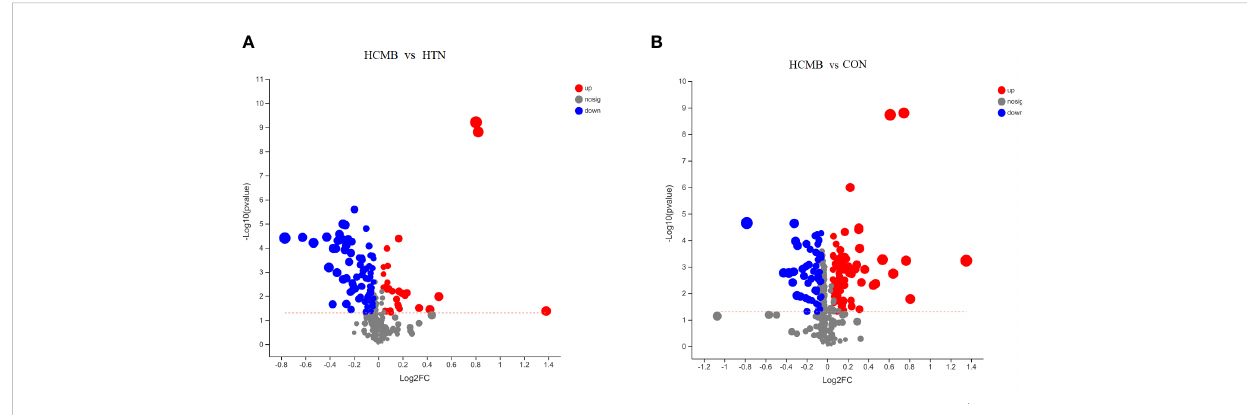
FIGURE 6 Volcano plots of the differences between groups. (A) . Volcano plots of intergroup differences between the two groups of HCMB vs HTN. (B) . Volcano plot of intergroup differences between two groups of HCMB vs CON. The horizontal coordinate of the graph is the value of the fold change in metabolite expression difference between the two groups, i.e. log2FC, and the vertical coordinate is the value of the statistical test for the difference in metabolite expression change, i.e. -log10(p_value), the higher the value the more signi fi cant the expression difference, the values of the horizontal and vertical coordinates have been logarithmicized. Each point in the graph represents a speci fi c metabolite and the size of the point indicates the Vip value. The points on the left are metabolites with down-regulated expression differences and the points on the right are metabolites with up-regulated expression differences, with the more signi fi cant expression differences occurring to the left, right and top of the graph. CON, control group; HTN, hypertension; HCMB, hypertensive cerebral microbleeds.